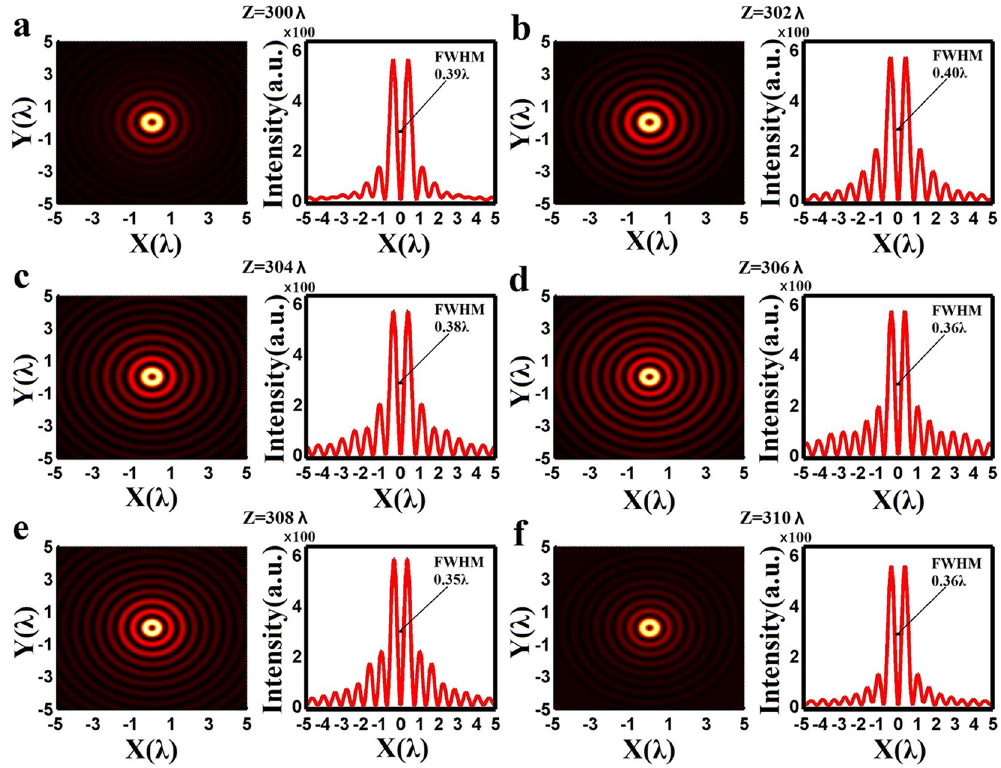
Figure 2. ( a ) – ( f ) The 2-dimentional color maps of the optical intensity distribution in the XY-plane and the optical intensity distribution curves along the x-axis obtained from Eq. (2) using the vectorial angular spectrum method at different propagation distances of 300 λ , 302 λ , 304 λ , 306 λ , 308 λ , and 310 λ , respectively, where the intensity is plotted in arbitrary